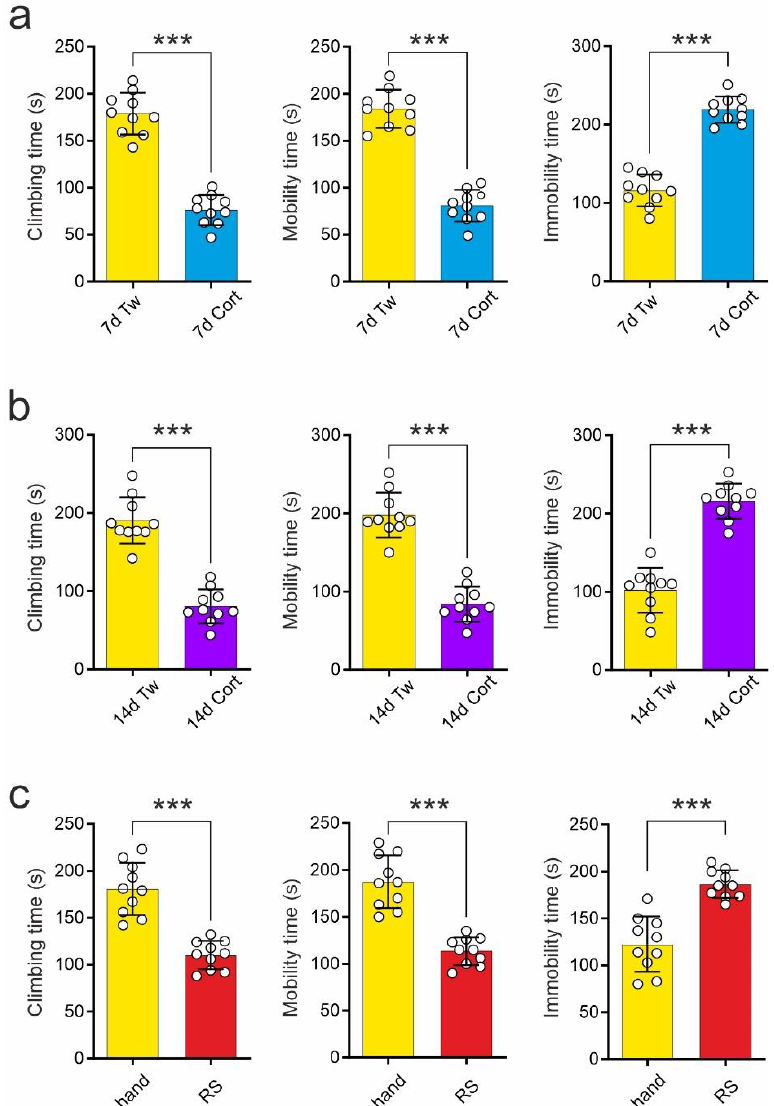
Figure 1. Repeated corticosterone administration lasting 7 days (7d Cort; ( a )) or 14 days (14d Cort; ( b )) and restraint stress (RS; ( c )) result in a decrease in climbing time (left) and mobility time (middle) and in an increase in immobility time (right) in the forced swim test compared to control animals receiving vehicle (7d Tw or 14d Tw) or handling (hand), respectively. Shown are mean values ± SEM with circles representing each rat’s performance. *** p < 0.001.